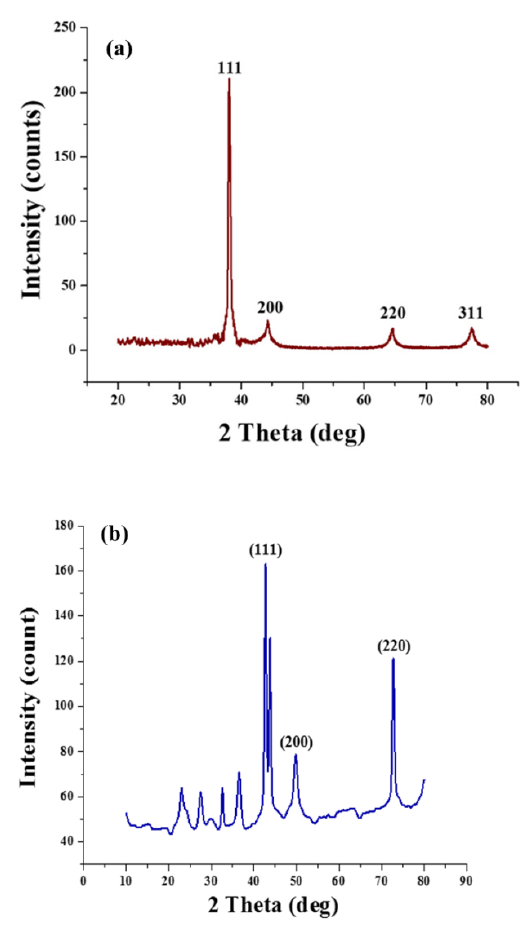
Figure 7. XRD analysis: ( a ) silver-coated cotton and ( b ) copper-coated cotton.